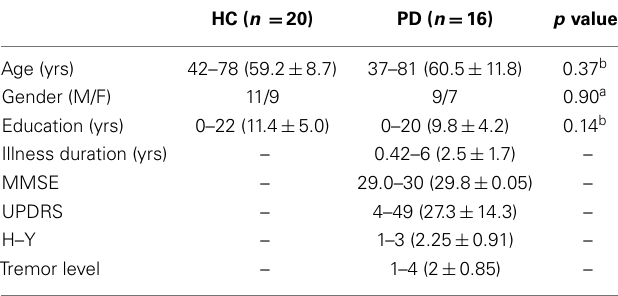
Table 1 | Demographics and clinical characteristics of the participants